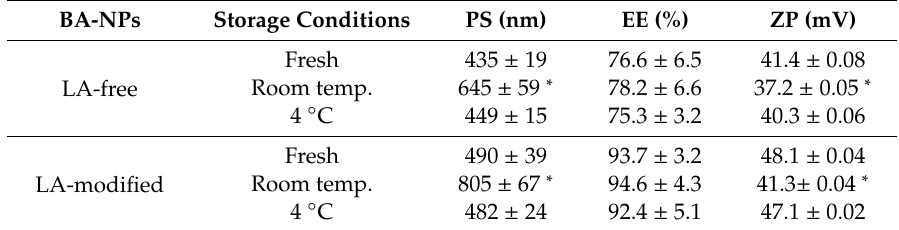
Table 4. Mean ± (SD) particle size (PS), entrapment e ffi ciency (EE%) and zeta potential (ZP) of BA-loaded-LA-free-CL-NPs and BA-loaded-LA-modified-CL-NPs after 15-day storage at room temperature or 4 ◦ C.